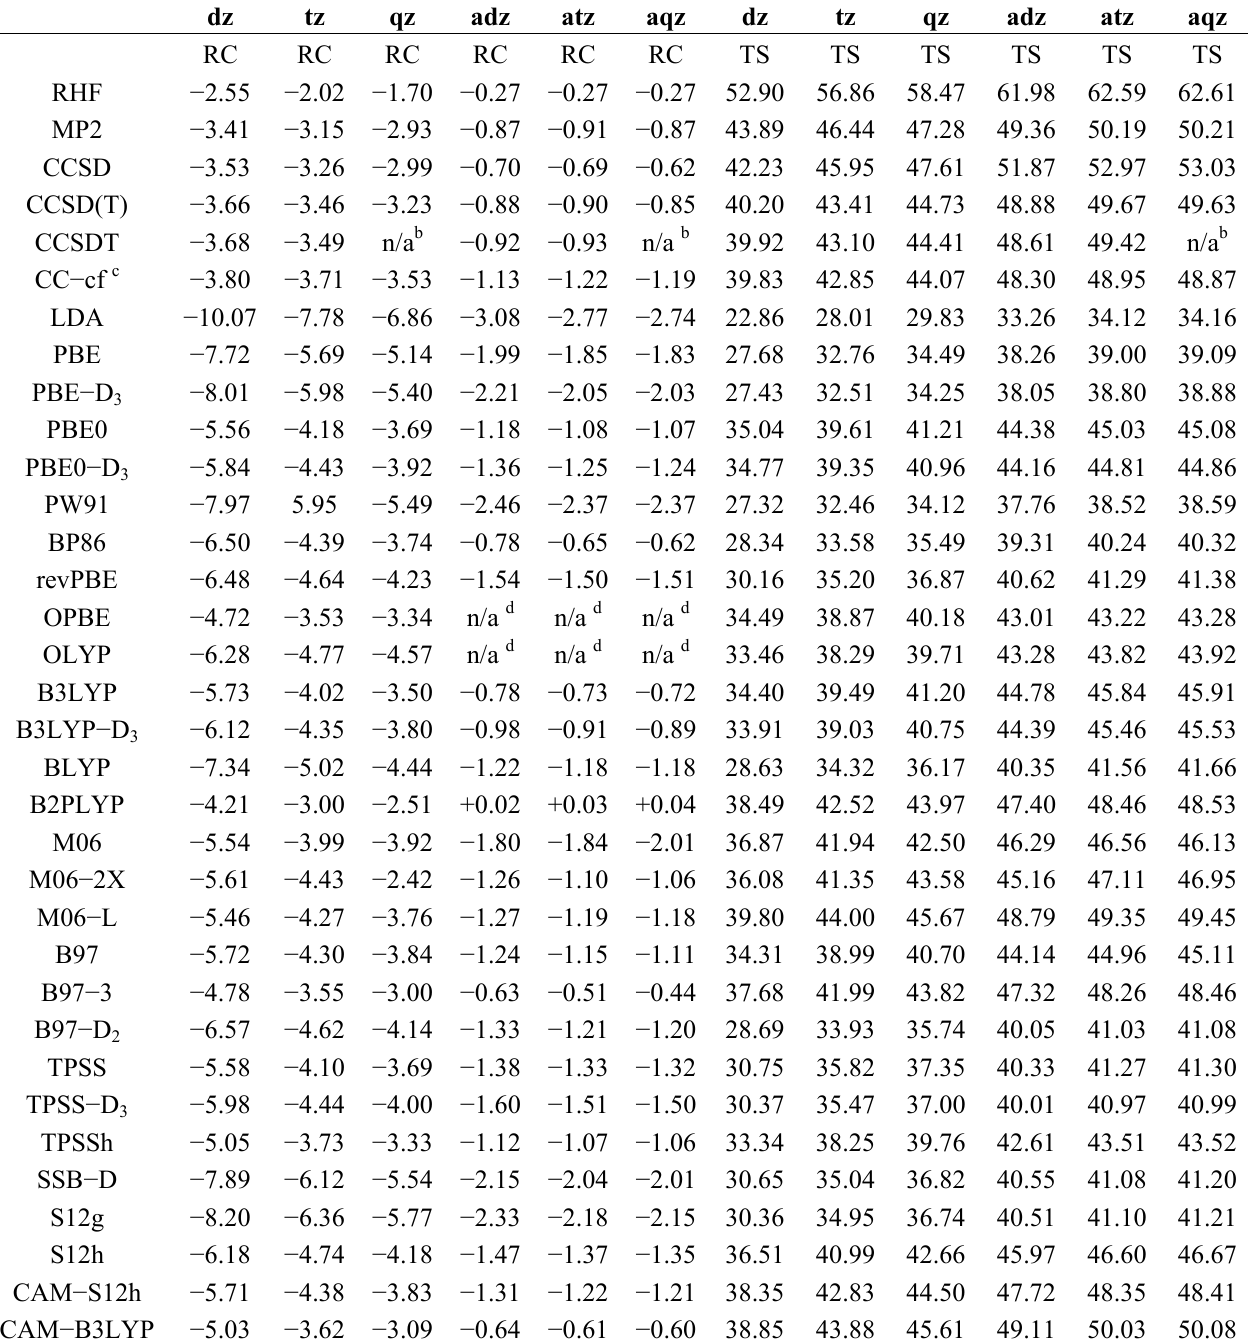
Table 1. Relative energies (kcal·mol − 1 ) obtained with wavefunction and density functional methods a